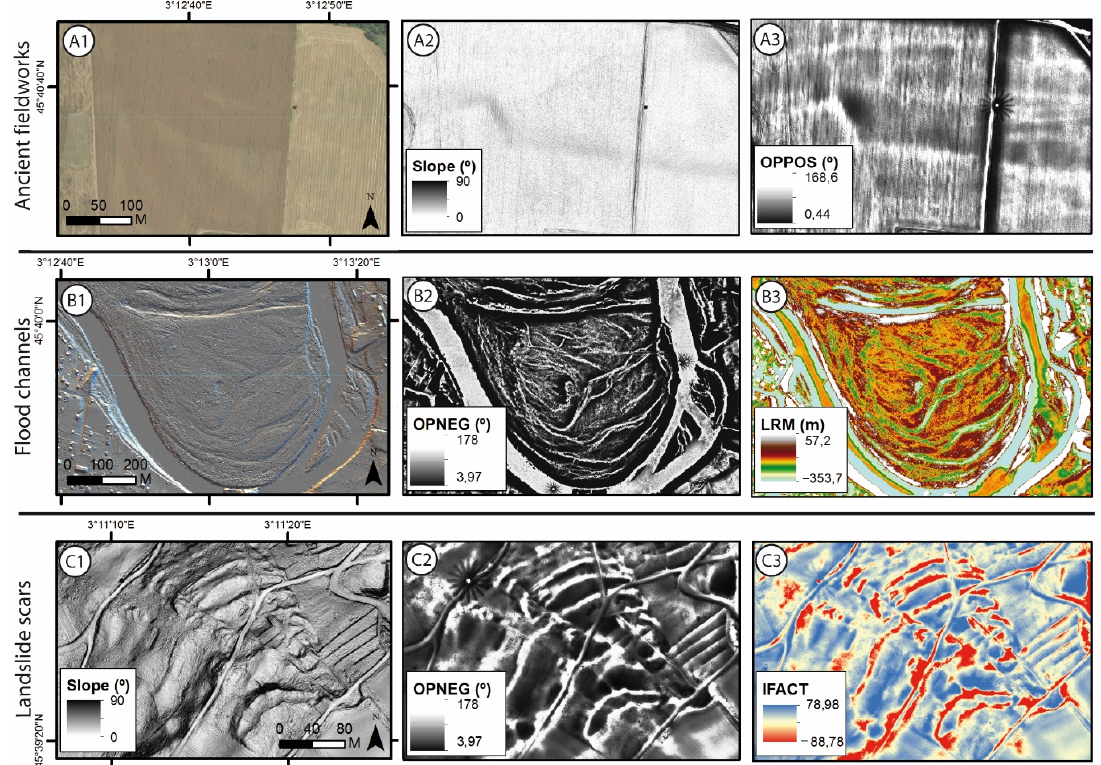
Figure 3. Selected areas (ancient field patterns in a flat fluvial terrace, flood channels, and landslide scars in steep slopes) under some VTs. The stretch type is given in parenthesis. ( A1 ) Aerial imagery (source: CRAIG, 2013); ( A2 ) Slopevis (Hist. Eq.); ( A3 ) Positive Openness (StD); ( B1 )